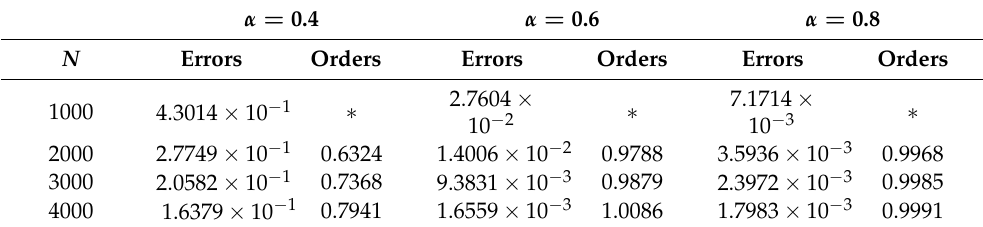
Table 2. Errors and orders in temporal direction for Scheme II (Example 1).